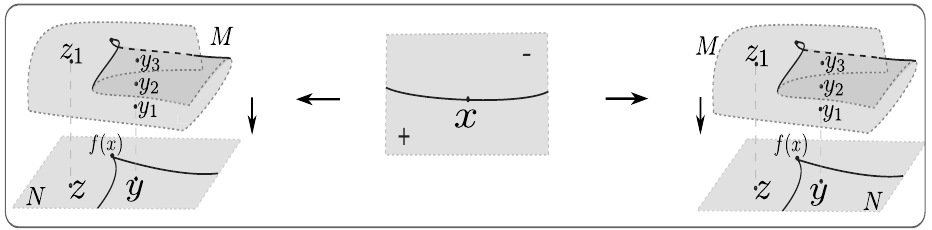
Figure 6. Negative and positive cusps.